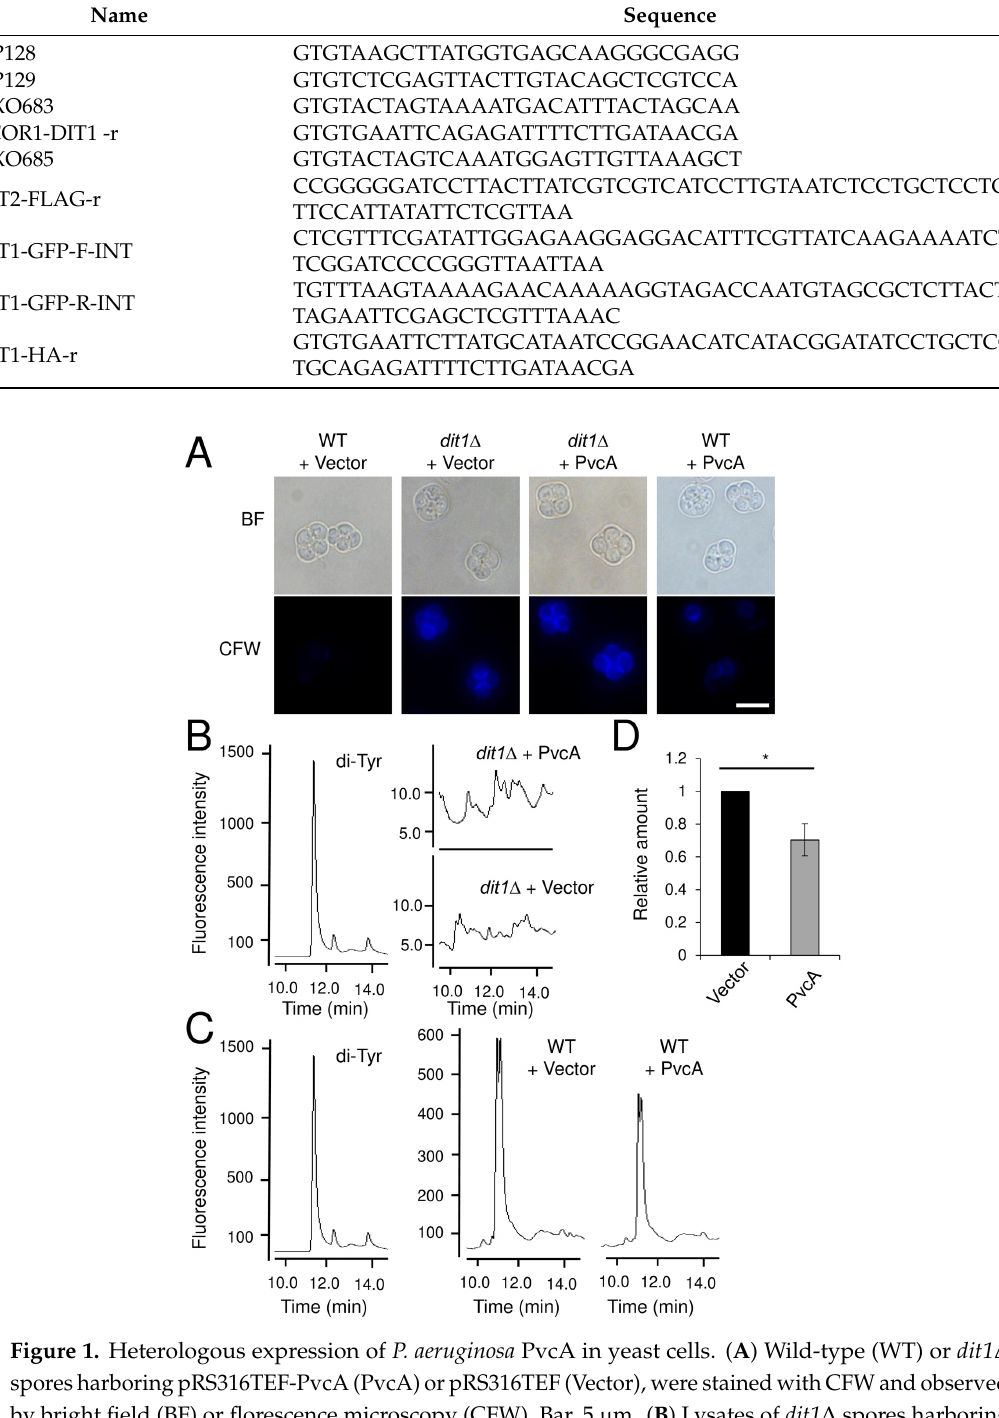
Table 2. Oligonucleotide primers used in this study.